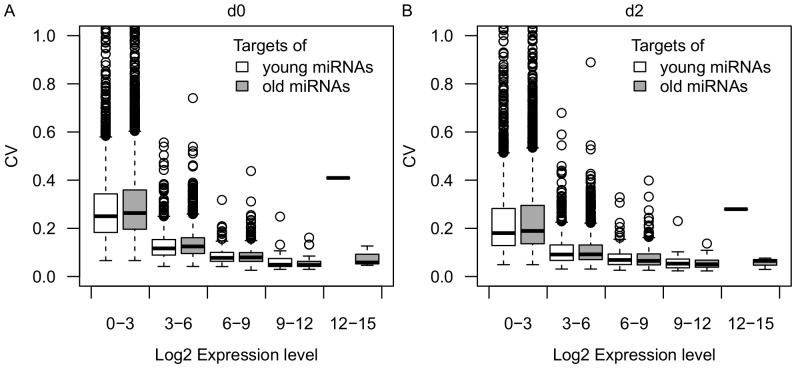
Distribution of CV for targets of young and old miRNAs.Boxplot of CVs for targets of young miRNAs (n = 4162) and targets of old miRNAs (n = 7415) under different expression bins (log2FPKM: 0–3, 3–6, 6–9, 9–12, 12–15) at day 0 (A) and day 2 (B).